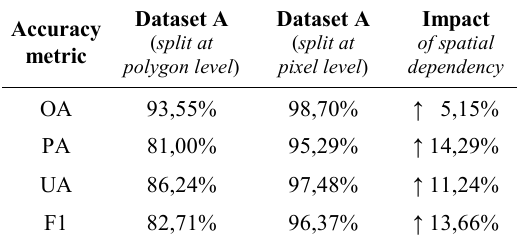
Table 3. Accuracy metrics derived with different splitting strategies and their impact in estimated map